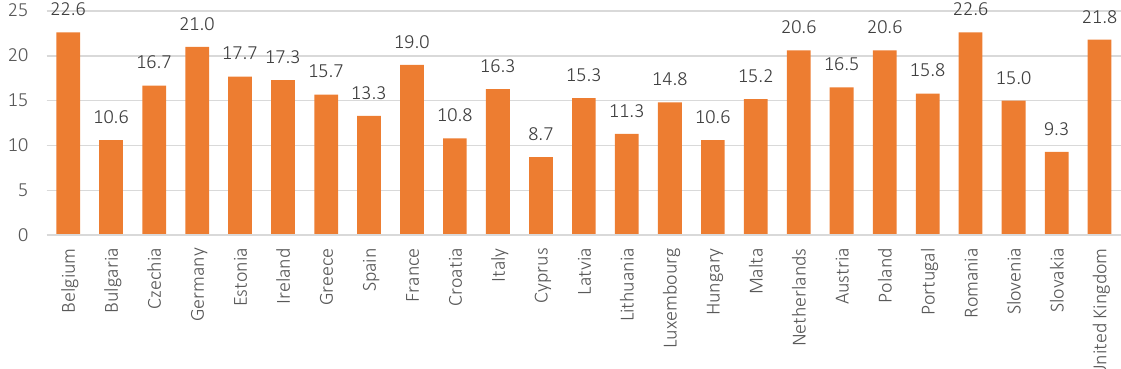
Figure 3. Employed persons by the flexibility to decide on working time by a country – persons can fully decide as % of employed persons